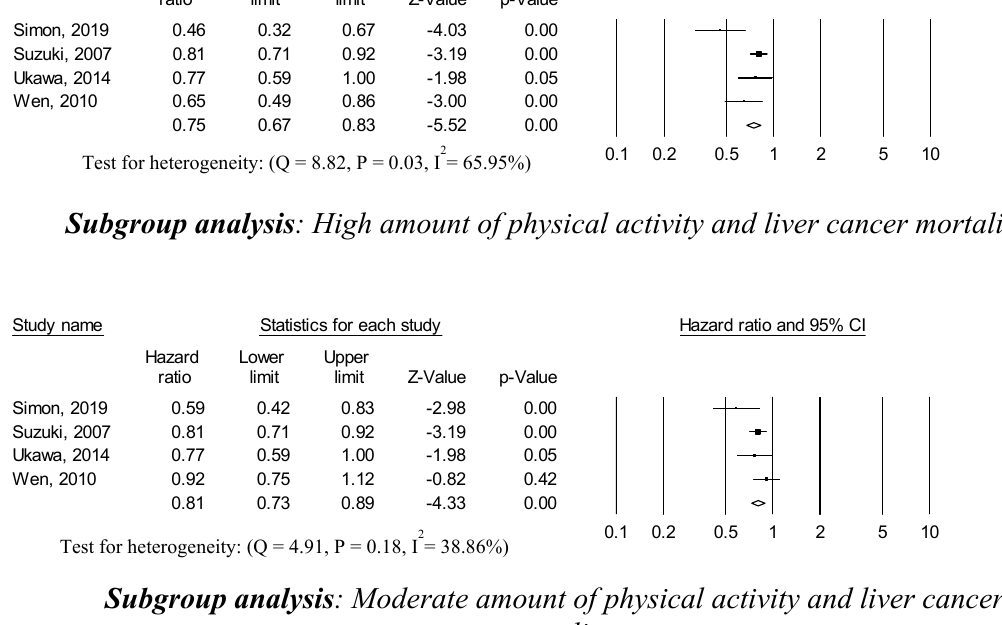
Figure 4. Physical activity, and liver cancer Figure 4 . Physical activity, and liver cancer mortality